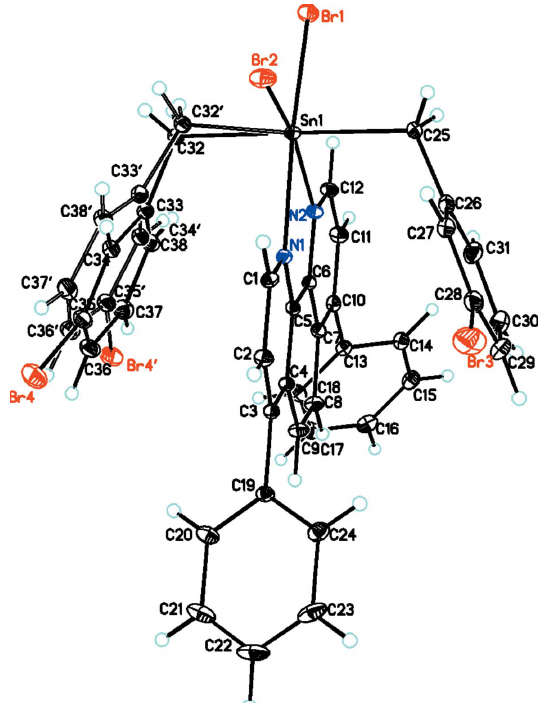
Figure 3 Packing diagram for (I), showing both the formation of R 2 to the formation of intermolecular Br (cid:2)(cid:2)(cid:2) Br interactions, as well as the C— H (cid:2)(cid:2)(cid:2) Br interactions linking these dimers into a two-dimensional layer (all interactions are shown as dashed lines).